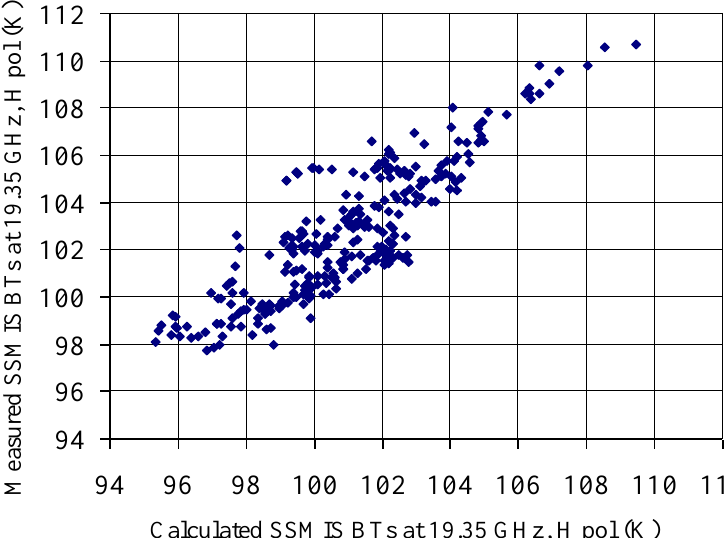
Figure 4. DMSP F16 SSMIS brightness temperatures measured at 19.35 GHz, horizontal polarization versus calculated brightness temperatures using Turn09 model for water vapor absorption, Liebe87 model for oxygen absorption and Chapr12 model for ocean emission wind dependency model